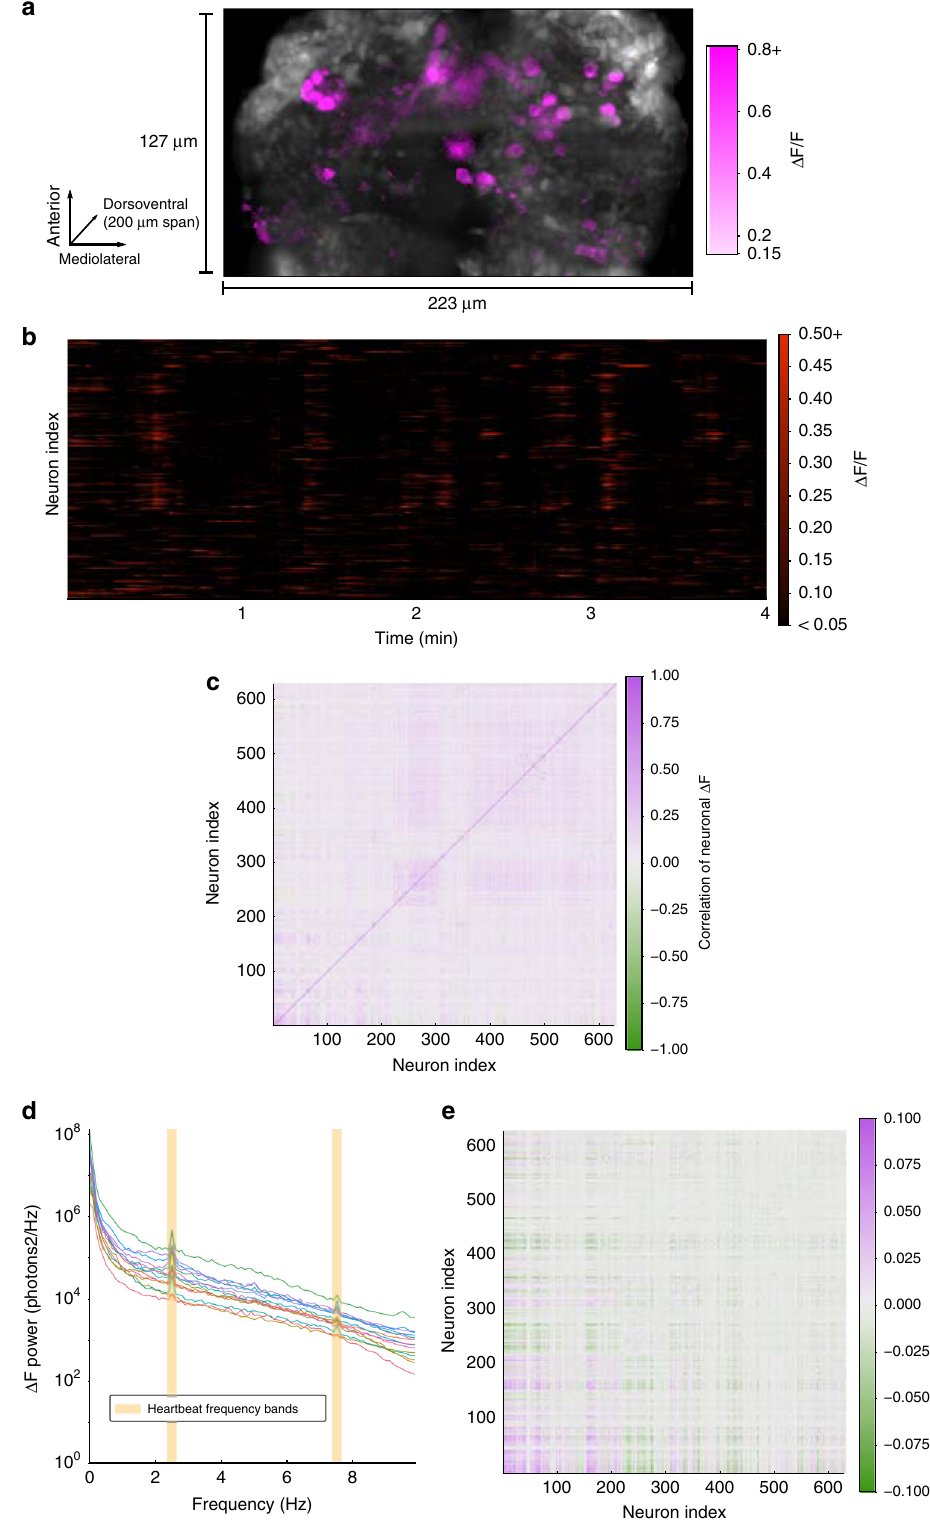
timepoint (see Methods section). Activity within individual slices is visualized in realtime in Supplementary Movie 2. We seg- mented a subset of 629 neurons by manually selecting regions of interest (ROIs), and we extracted Δ F / F timeseries (see Methods section). A raster plot of cellular activity during the fi rst 4 min of the recording is shown in Fig. 4b. Figure 4c shows